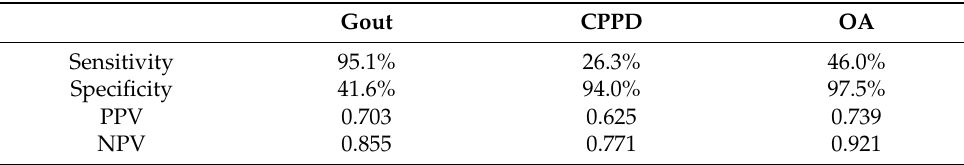
Figure 3. Conditional inference tree analysis for the classification of diagnoses based on clinical biomarkers. Reliable diagnostic predictions were possible using just the four biomarkers (uric acid, CRP, arterial hypertension, and sex) to differentiate gout (sensitivity 95.1%, specificity 41.6%), CPPD (sensitivity 26.3%, specificity 94.0%), and OA (sensitivity 46.0%, specificity 97.5%) in our patient population. Numbers above biomarkers represent node numbers. CRP: C-reactive protein; OA: osteoarthritis; CPPD: calcium pyrophosphate deposition disease. Table 4. Diagnostic performance of conditional inference tree analysis.